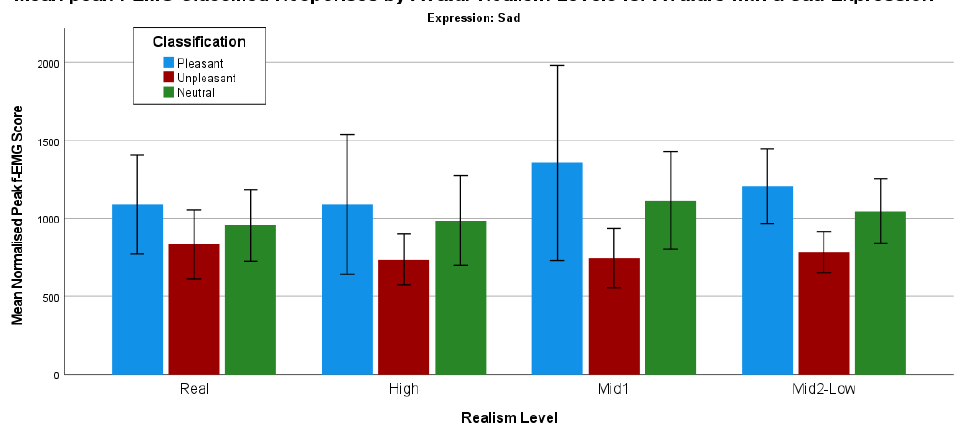
Figure 9. Mean peak f-EMG classified responses by avatars with a sad expression grouped by realism level.